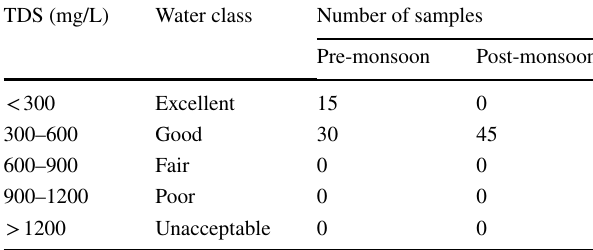
Table 6 Classification of groundwater samples WHO (2011) col- lected from the proximity of Beas River, India